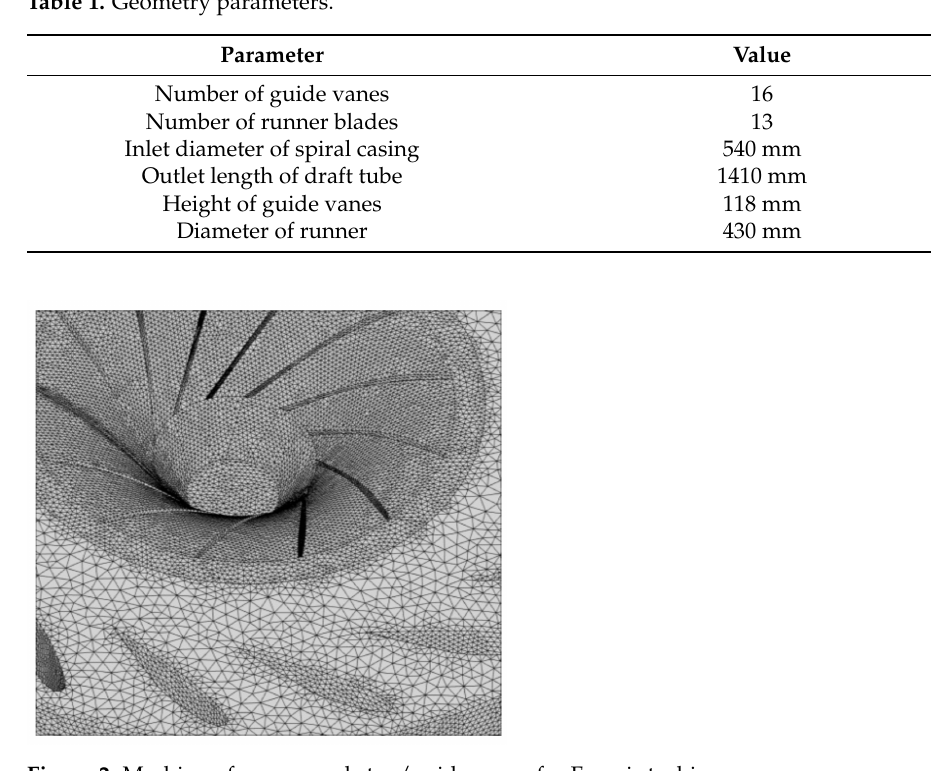
Figure 2. Meshing of runner and stay/guide vanes for Francis